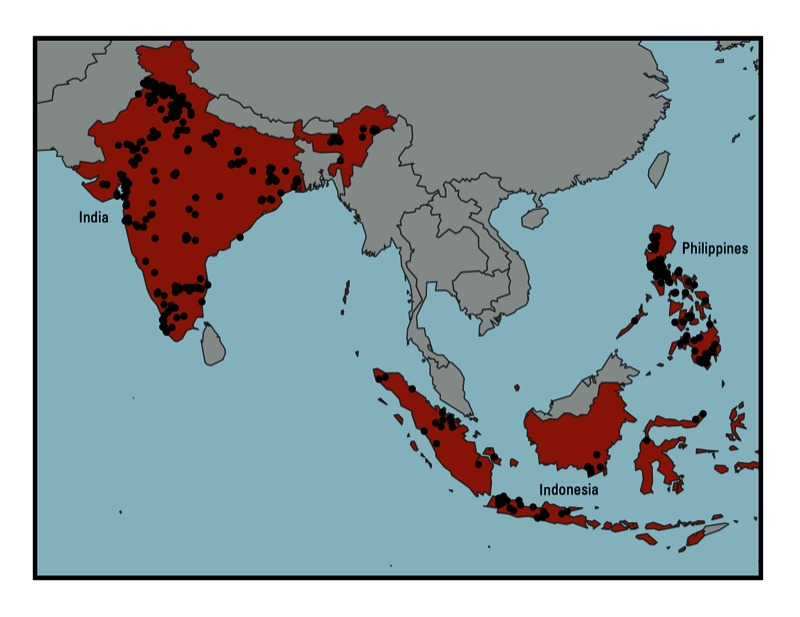
Locations of 373 toxic waste sites in India, Indonesia, and the Philippines in 2010.